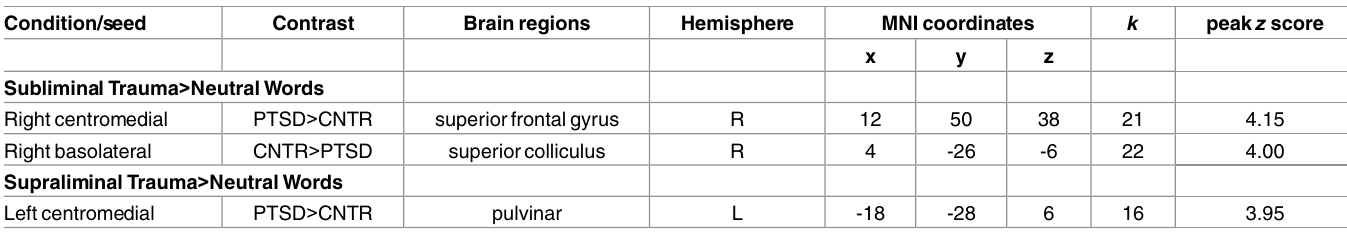
Table 2. Functionalconnectivity of each amygdala subdivision duringsub-and supraliminaltrauma-relatedword processing.